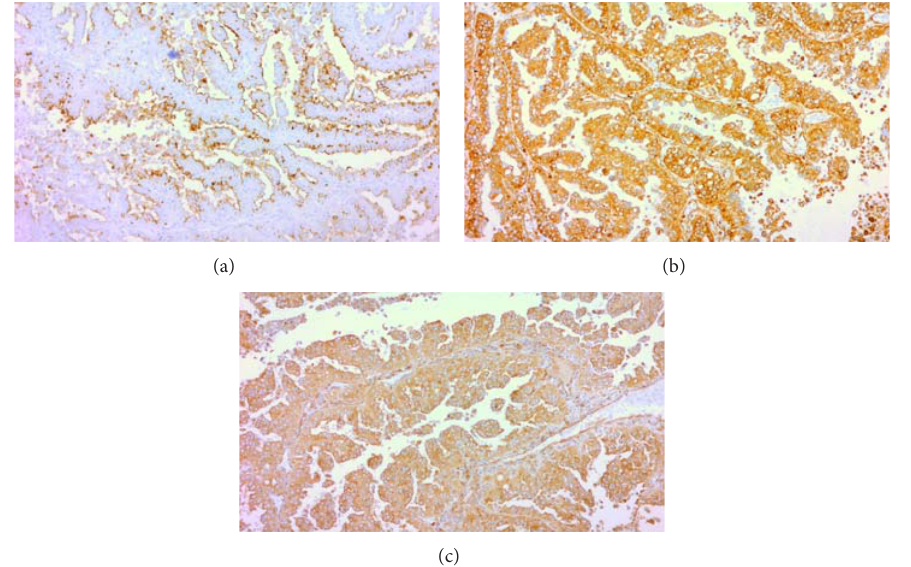
Figure 4: (a) Reactivity to EMA. Immunohistochemical stain with anti-EMA antibody, × 100. (b) Reactivity to Vimentin. Immunohistochem- ical stain with anti-Vimentin antibody, × 100. (c) Reactivity to AMACR. Immunohistochemical stain with anti-AMACR antibody, ×